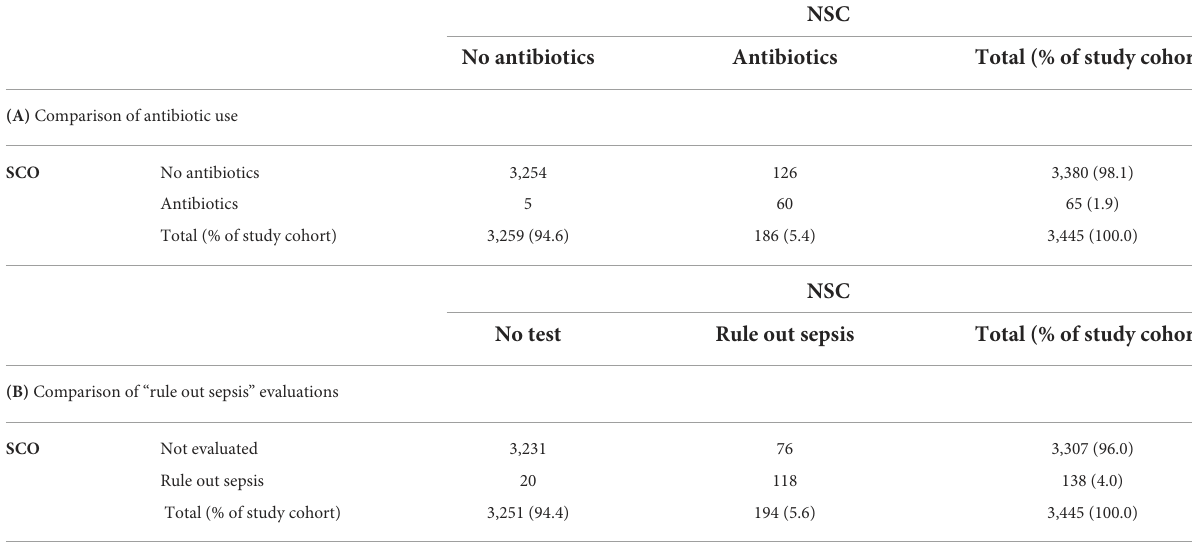
TABLE 4 Comparison of antibiotic use (A) and “rule out sepsis” evaluations (B) as per SCO vs. recommendations of the NSC in the study population. Differences between proportions were analyzed using McNemar’s test.